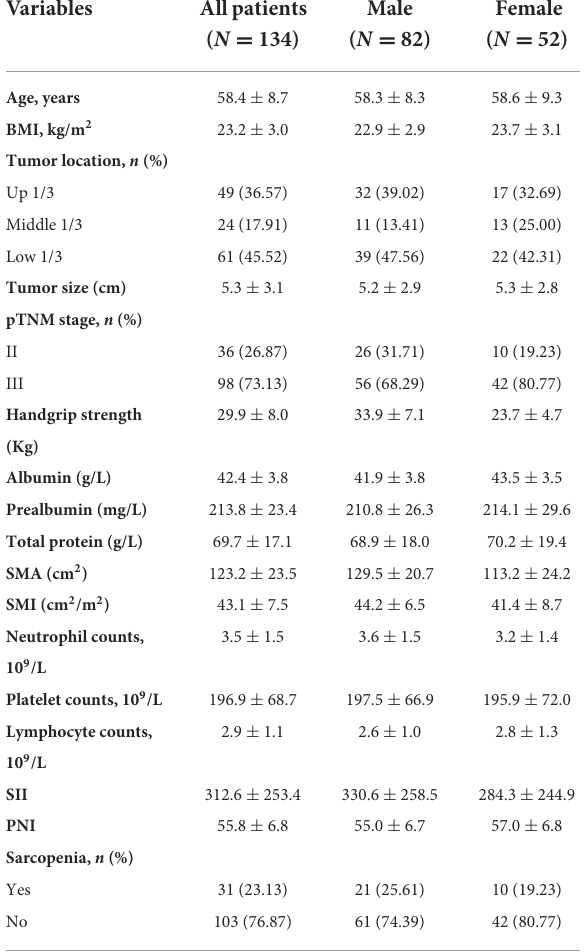
TABLE 1 Demographic and clinical characteristics of the patients with cancer.